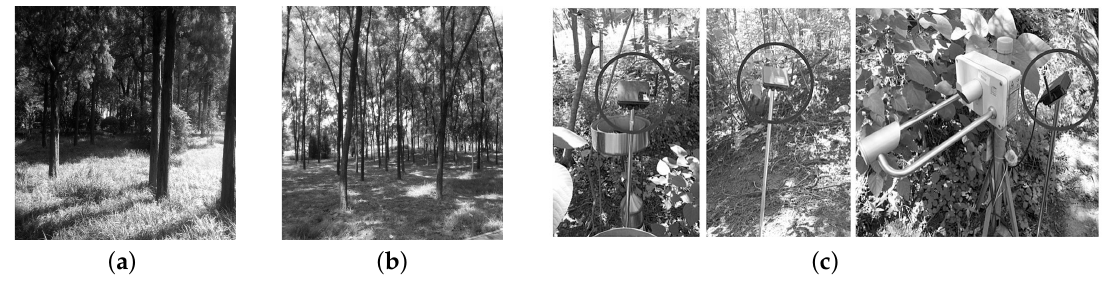
Figure 1. Three typical forest environments. ( a ) Campus forest; ( b ) Bajia Rural Park forest; ( c ) Jiufeng Mountain